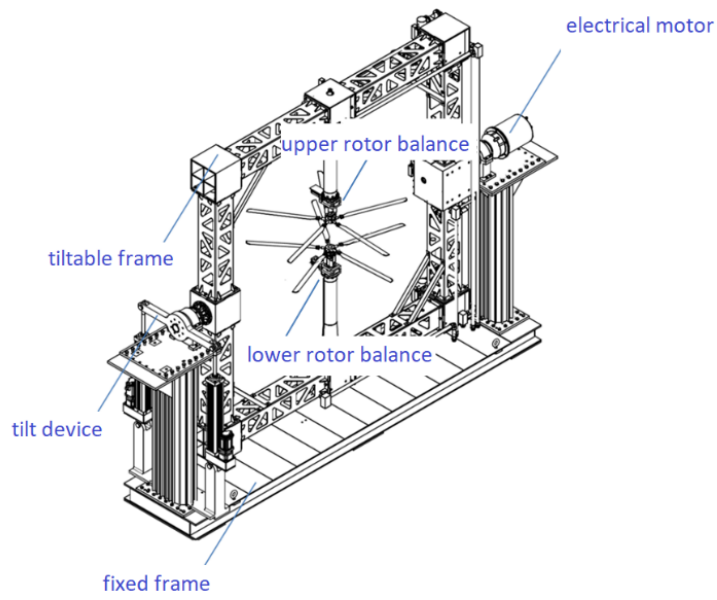
Figure 1. The Φ 2 m coaxial rigid rotor test